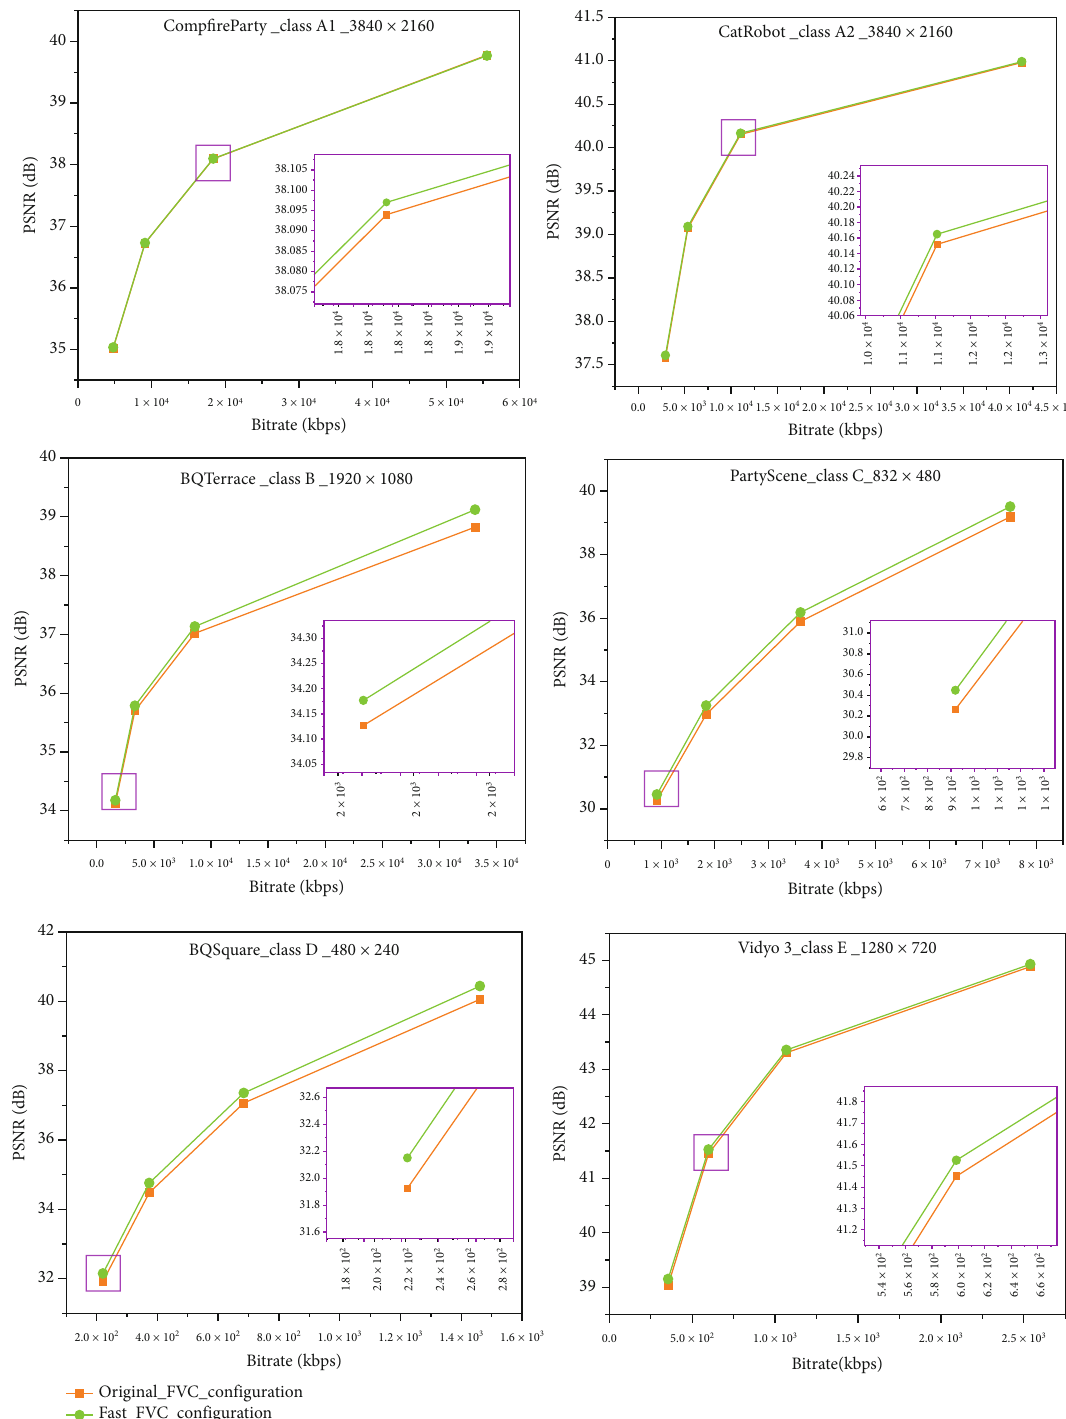
Figure 12: RD curves for various test